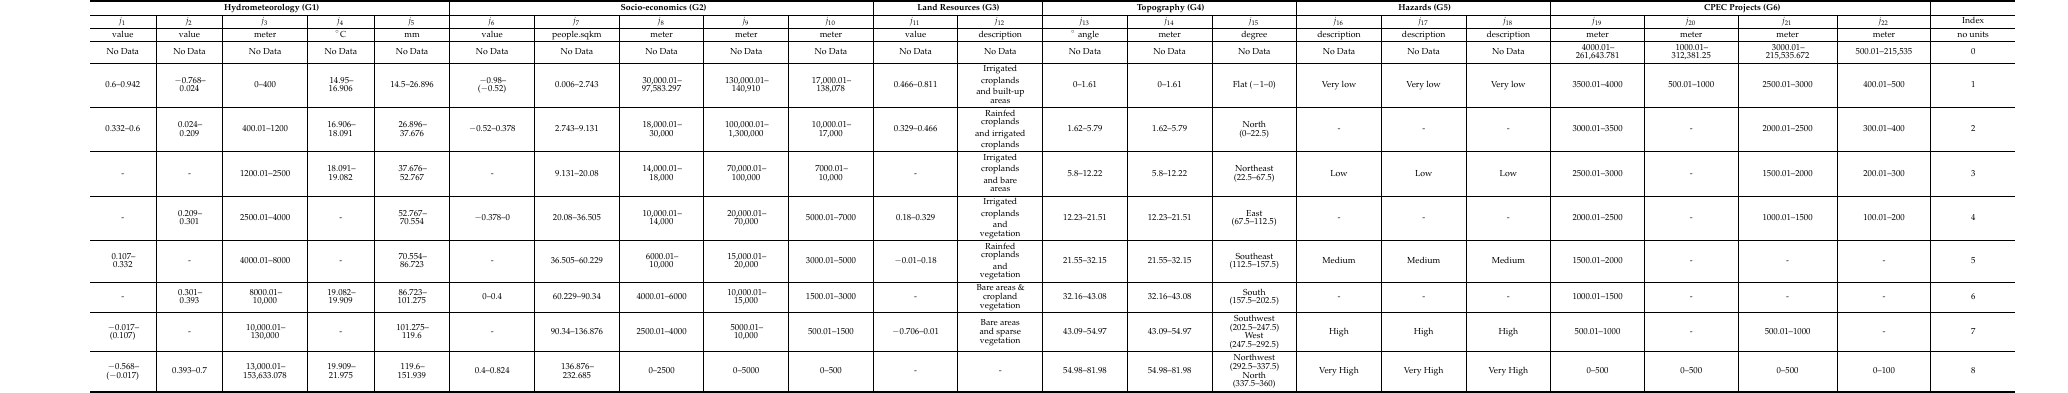
Table A1. Classification and index value assigned to twenty-two indicators of six